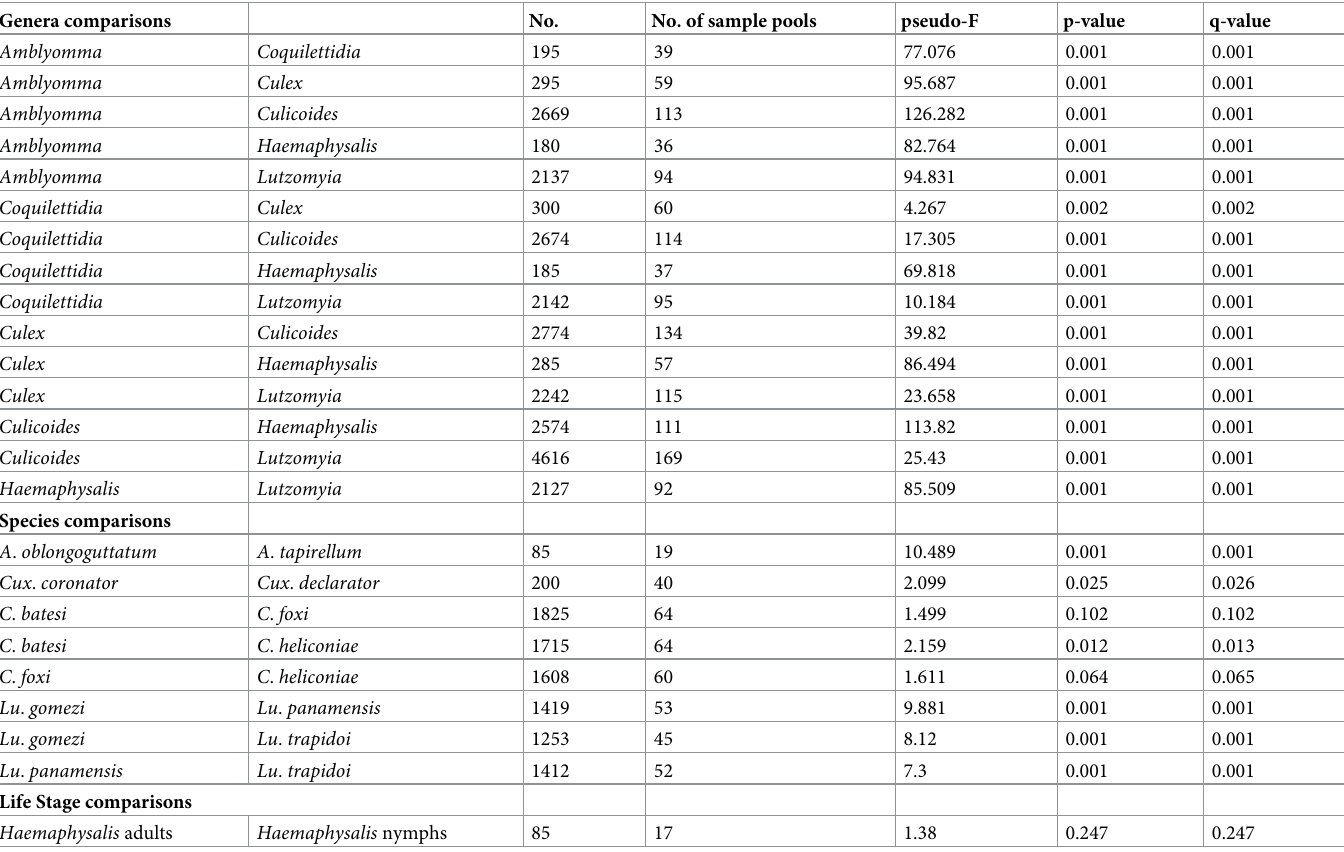
Table 2. Results of PERMANOVA test for the comparison of bacterial OTU’s among pools of six different genera and 10 different species (with within genera com- parisons) of blood-feeding arthropods based on unweighted UNIFRAC distances. Genera